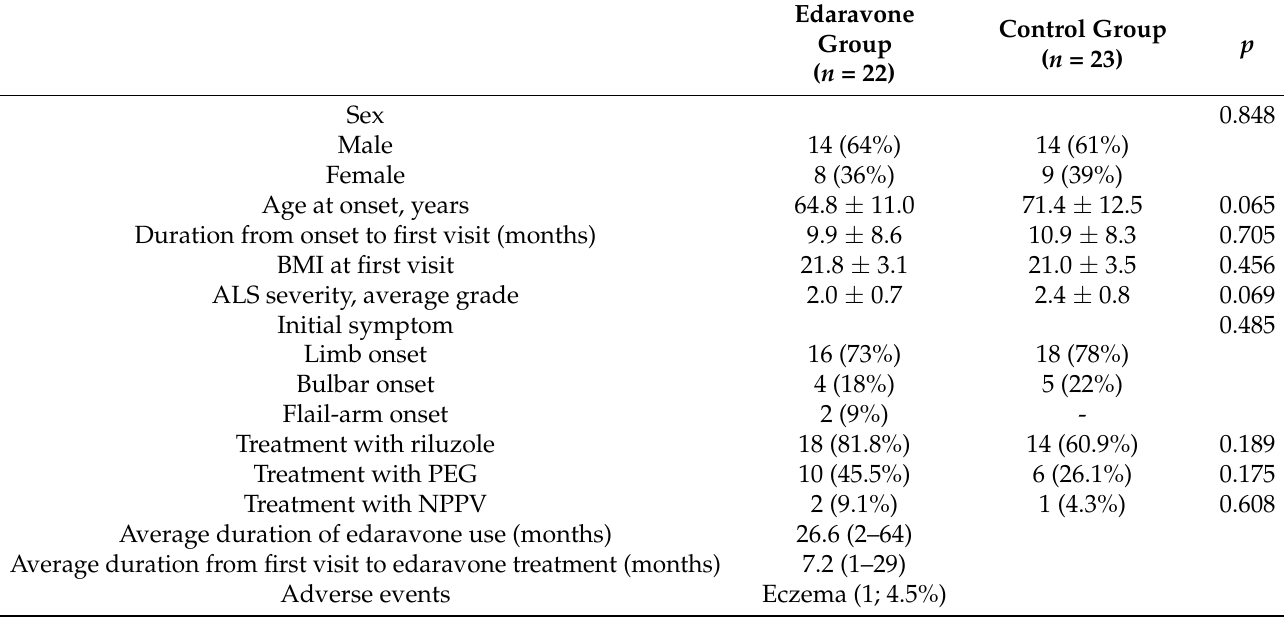
Table 1. Demographic and baseline characteristics of patients with amyotrophic lateral sclerosis treated with and with- out